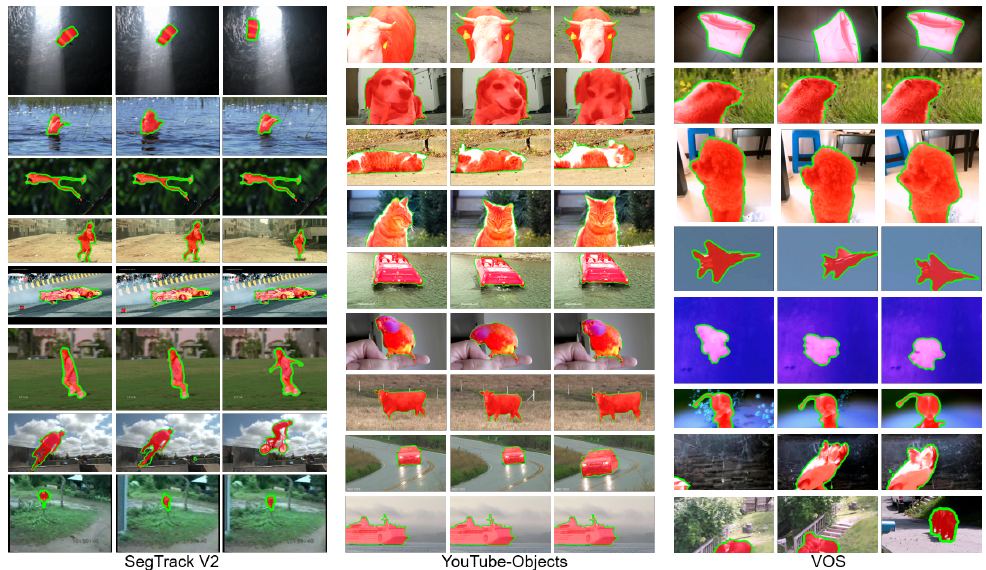
Figure 4. Representative results of our approach. Red masks are the ground truth, and green contours are the segmented primary